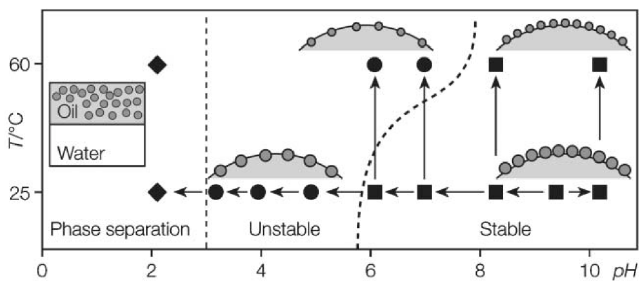
Figure 14. The stabilizing efficiency of poly(N-isopropylacrylamide) (PNIPAM) microgel particles for octanol-in-water emulsions as a function of pH and temperature. ■ : Stable, ● : Unstable, ◆ : Phase separation. (Arrows indicate the probed transitions). Reprinted with permission from [115]. Copyright 2004, Royal Society of Chemistry.